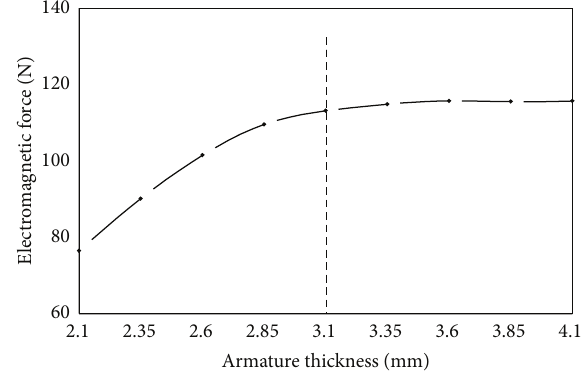
Figure 14: Influence of armature thickness on electromagnetic force.